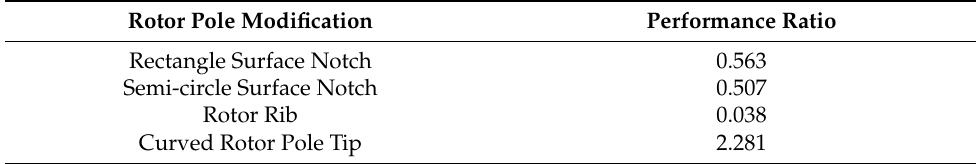
Table 12. Performance ratio comparison for the rotor pole tip modifications.